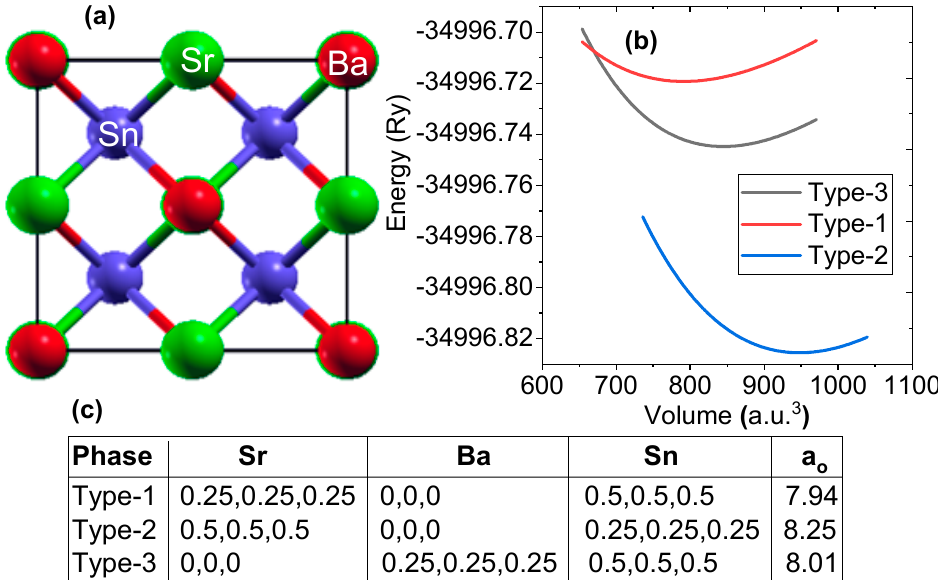
Figure 1. ( a ) Crystal structure of SrBaSn alloy in type-2 configuration. Red, green and blue colors represent Sr, Ba and Sn atoms, respectively, ( b ) energy versus volume curve and ( c ) possible atomic position of Sr, Ba and Sn atoms and lattice parameter (a o in Å) of SrBaSn Heusler structure within F43 m space group in three different structural arrangements.